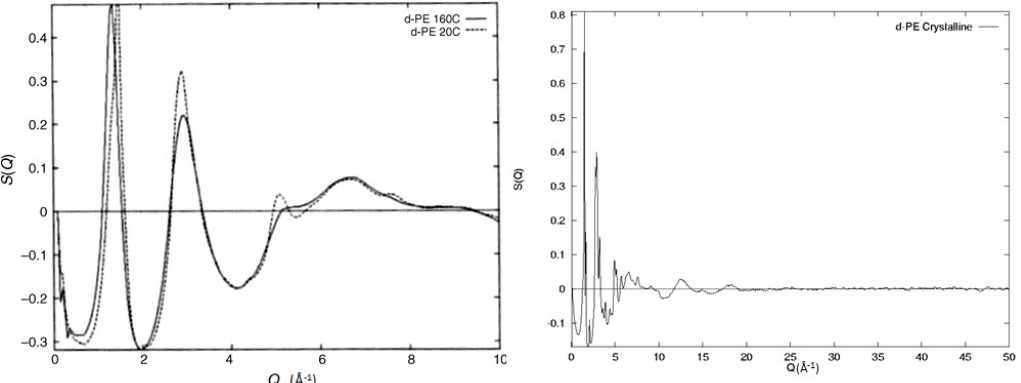
Figure 6. Experimentally observed structure factors from samples of deuterated polyethylene prepared with different methods. The solid line indicates the sample irradiated in the melt (160 °C), and the dashed line indicates the sample irradiated at room temperature (20 °C). On the right-hand side, the diffraction of the semi-crystalline deuterated polyethylene can be seen.